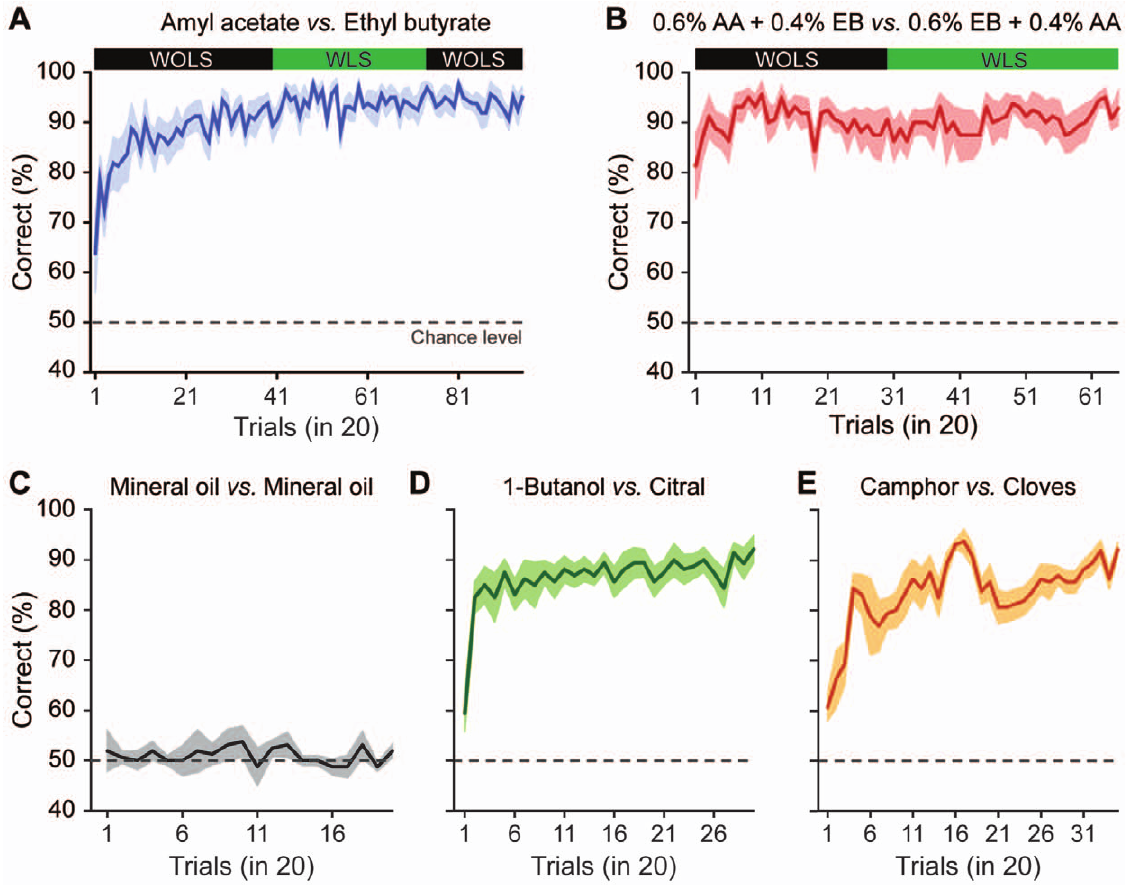
Figure 2. Mice learn simple as well as complex odorants with high accuracy under head-restrained conditions. Discrimination accuracy shown as the average percentage of correct choices: ( A ) amyl acetate vs ethyl butyrate (n=8 mice, average 6 sem), ( B ) complex binary mixtures of AA and EB, 0.6% AA + 0.4% EB vs. 0.6% EB + 0.4% AA (n=8 mice, average 6 sem). ( C ) Learning observed in all cases is olfactory specific, mice showed no learning when they were trained on a mineral oil vs mineral oil task (n=8 mice, average 6 sem). ( D ) citral vs 1-butanol (n=8 mice, average 6 sem) ( E ) cloves vs camphor (n=8 mice, average 6 sem).